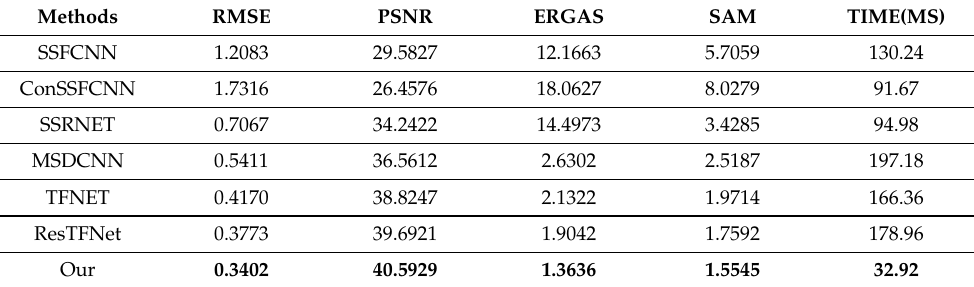
Table 6. Quantitative evaluation on the Botswana dataset (bold indicates the best results).